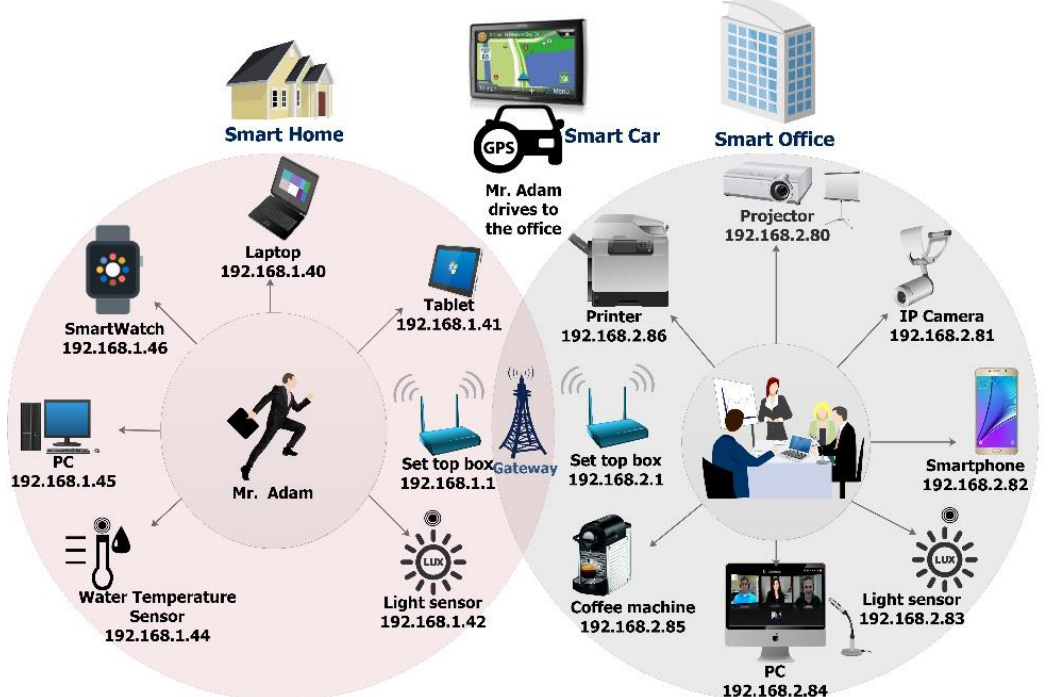
Figure 7. Possible scenarios.